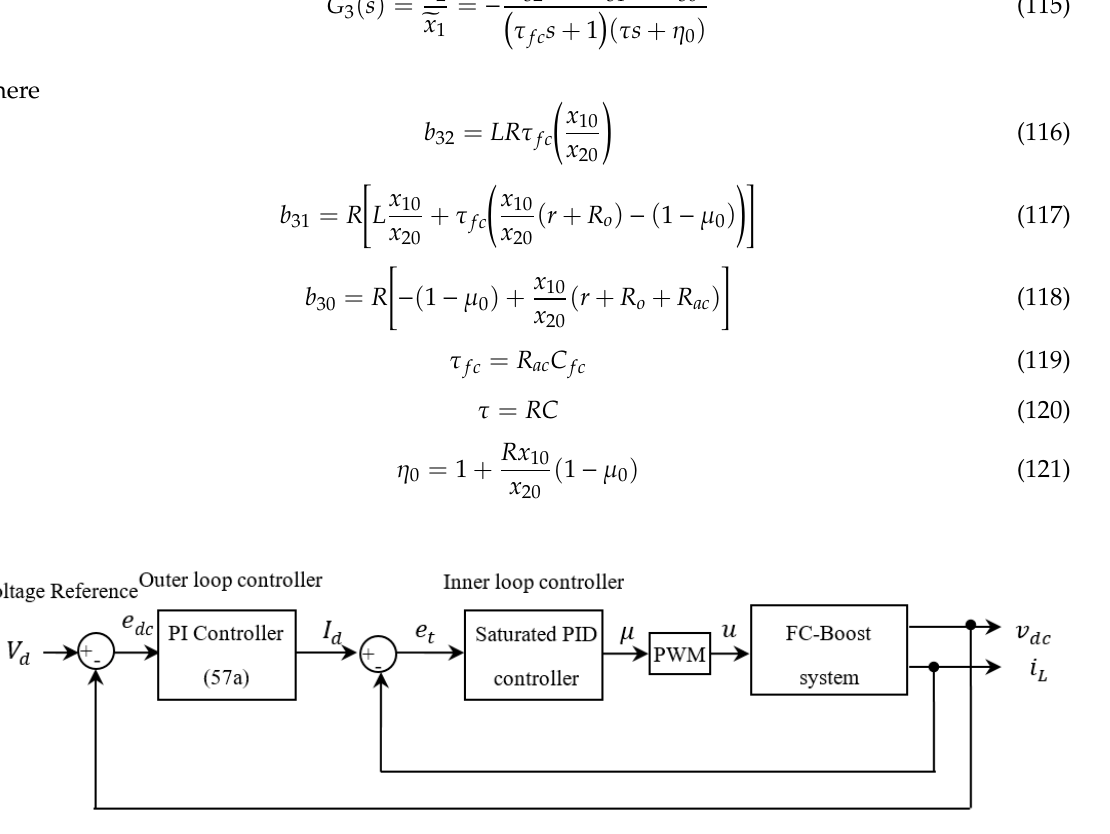
Figure 18. Cascade control structure of the FC-boost association.